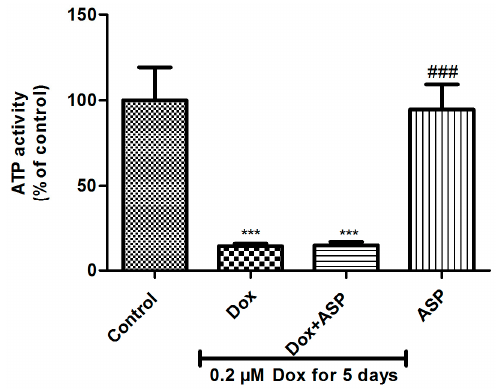
Figure 5. The effect of aspalathin (ASP) co-treatment on metabolic activity of Caov-3 cells exposed to Doxorubicin. Caov-3 cells were treated with either 0.2 µ M Dox alone or co-treated in combination with 0.2 µ M ASP, daily for 5 days. Control samples were exposed to either media only or 0.2 µ M ASP for 5 days. Results are expressed as the mean ± SEM of three independent biological experiments, each with three technical replicates ( n = 9). *** p ≤ 0.0001 versus control and ### p ≤ 0.001 versus Dox.